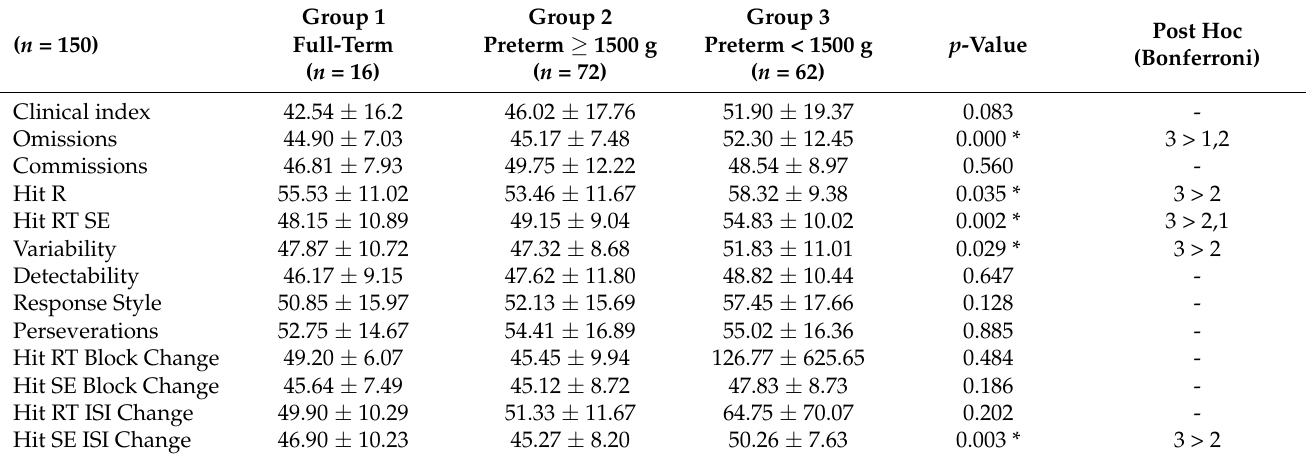
Table 2. Comparison of K-CPT variables between groups after adjusting for age, GA, BPD, and